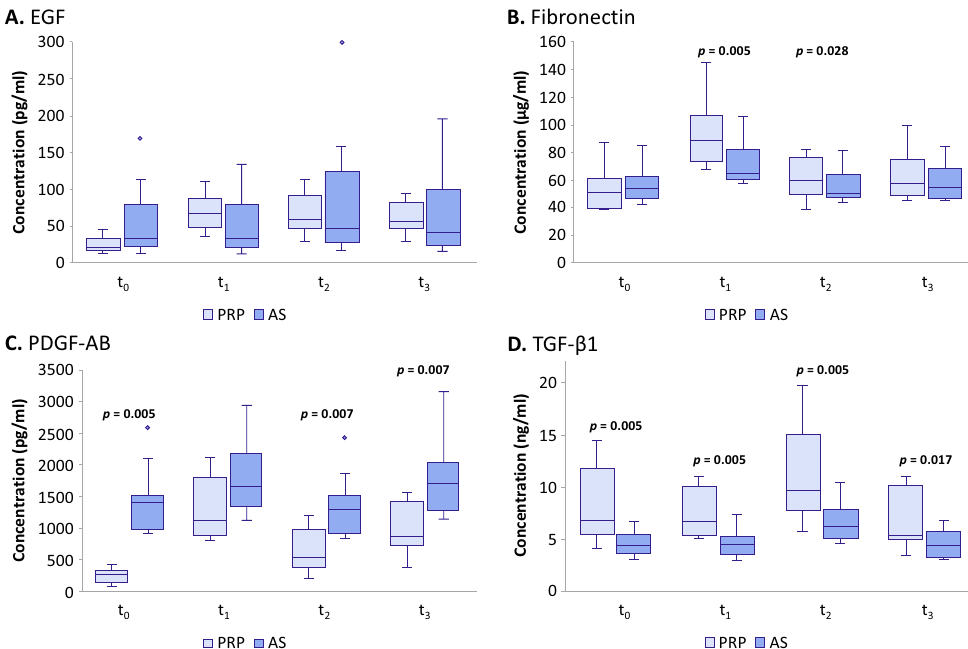
Figure 3. Concentrations of epitheliotrophic growth factors and fibronectin in 20% platelet-rich plasma (PRP) and 20% autologous serum (AS) at baseline (t 0 ), after storage at 4 °C for 1 week (t 1 ), and after storage at − 20 °C for 1 month (t 2 ) and 3 months (t 3 ). Median and interquartile range of concentrations are shown in box plots (N = 10 for each group). The presence of p- value above any pair of data signifies that the difference between concentrations in AS and those in PRP in that condition is statistically significant as analyzed by Wilcoxon signed rank test. Conversely, the absence of p -value above any pair of data signifies no statistically significant difference for that comparison. The factors shown here are: ( A ) EGF, ( B ) fibronectin, ( C ) PDGF-AB, and ( D )